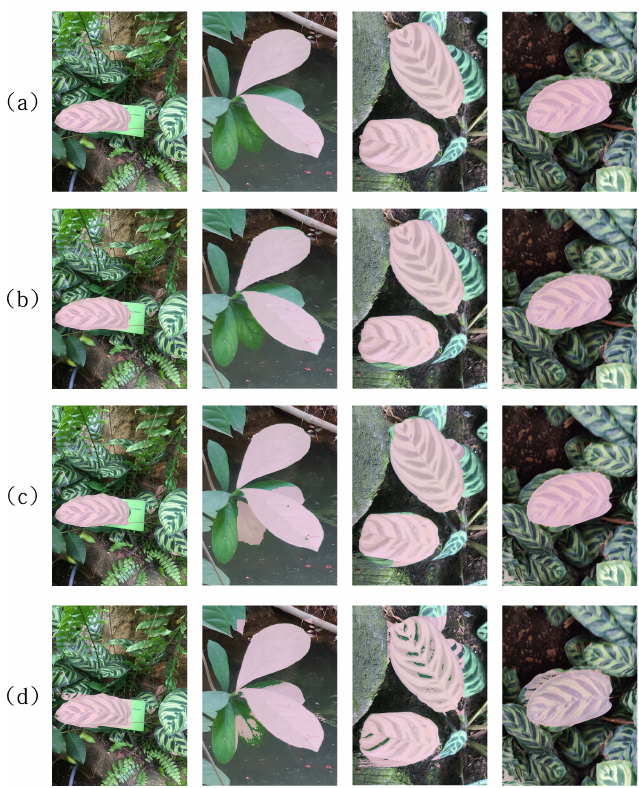
Figure 8. Manual labeling results and algorithm segmentation results: ( a ) manual labeling results, ( b ) the designed segmentation method results, ( c ) Grabcut results, and ( d ) Otsu segmentation algorithm